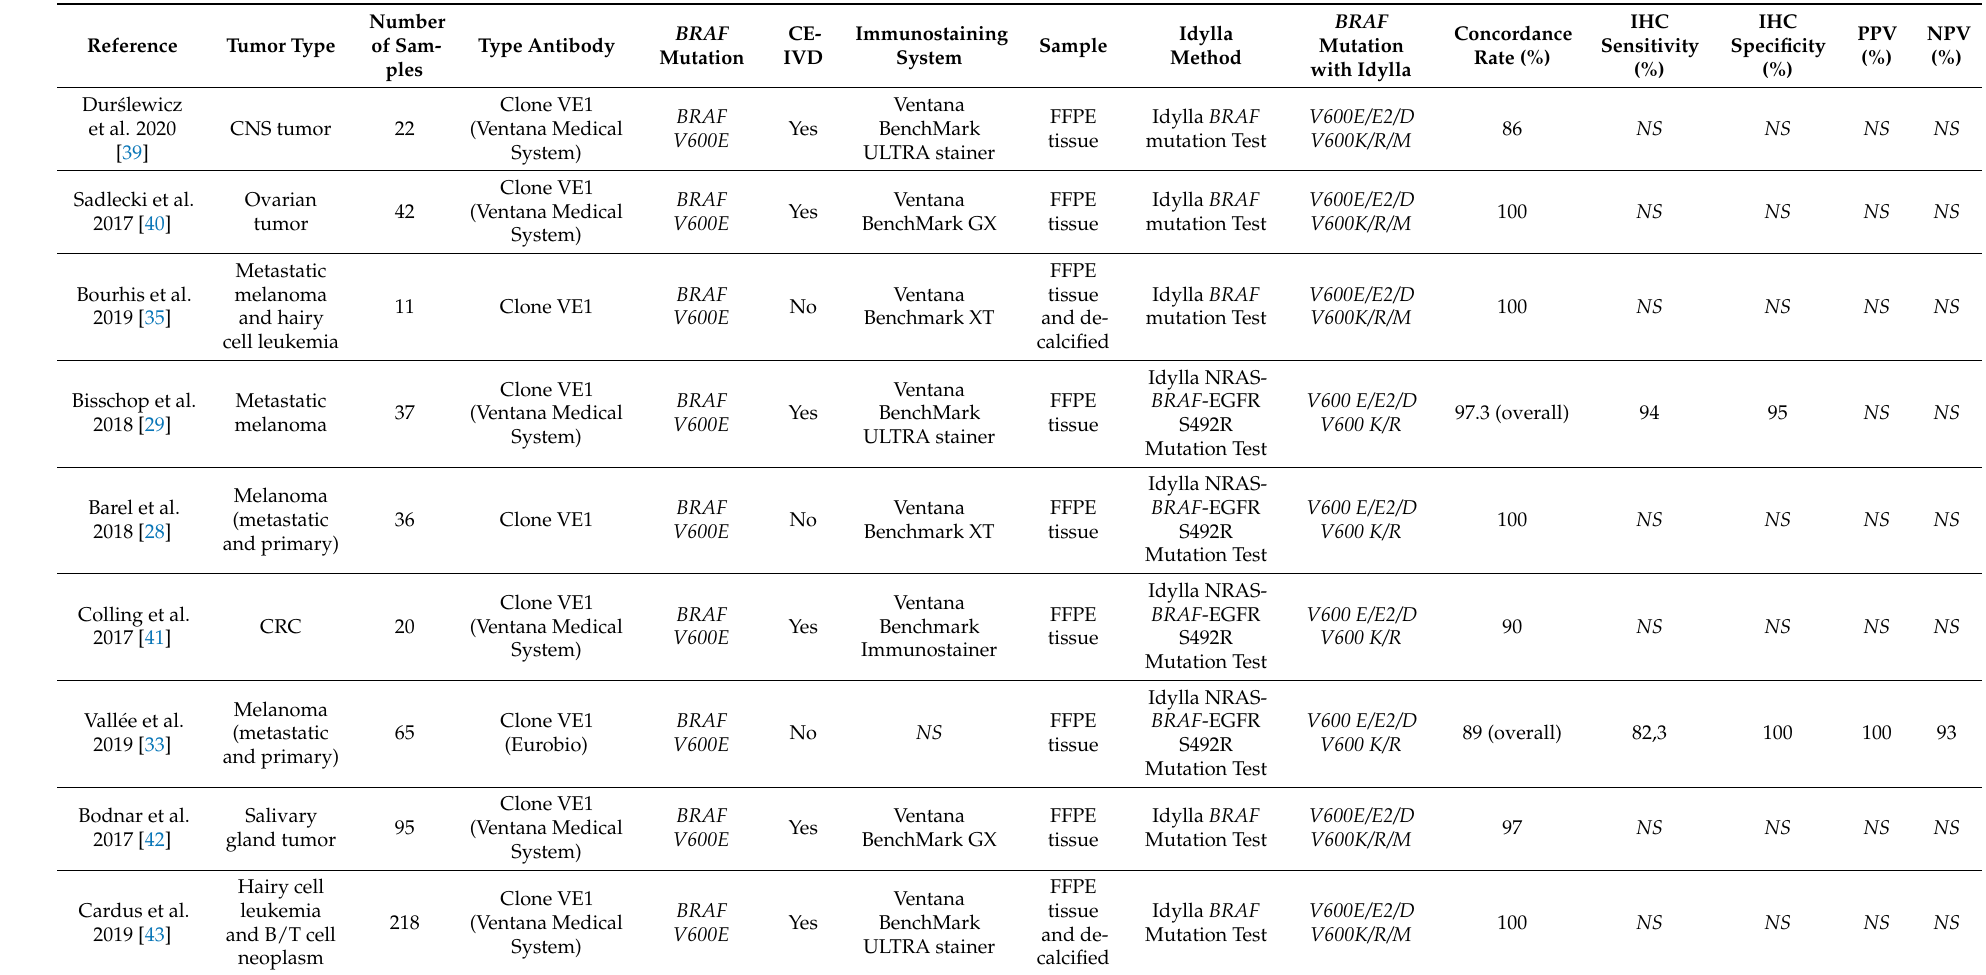
Table 6. Overview of studies combining immunohistochemistry and Idylla for BRAF